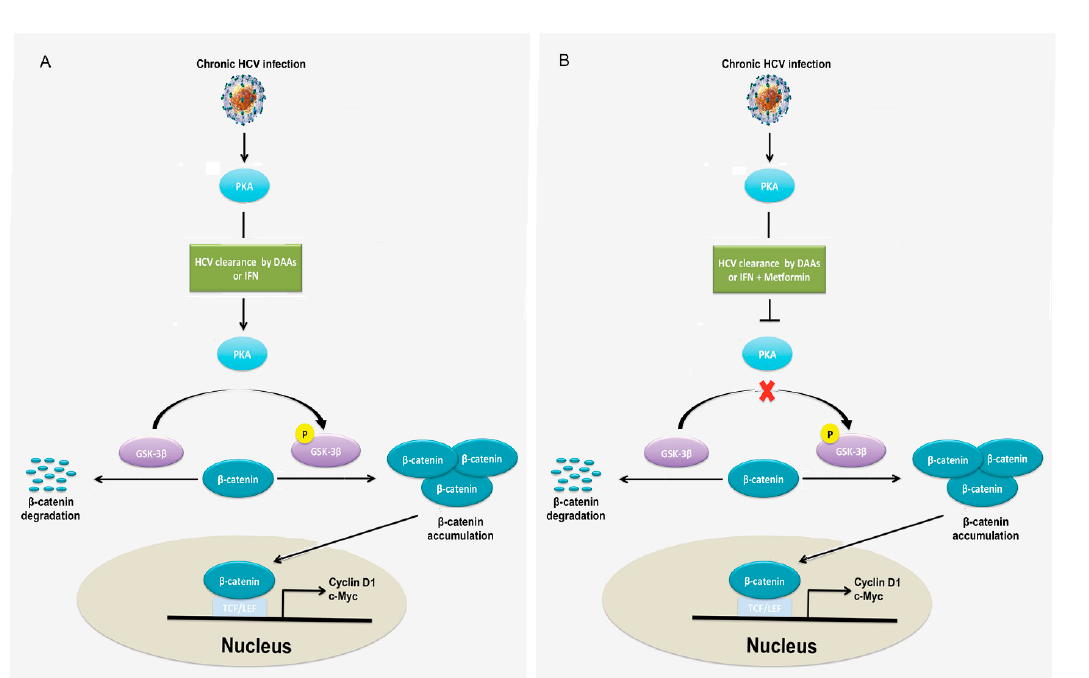
Figure 6. Schematic diagram of the Wnt/ β -catenin signaling pathway in chronic HCV infection and HCV clearance without ( A ) or with ( B ) metformin treatment.